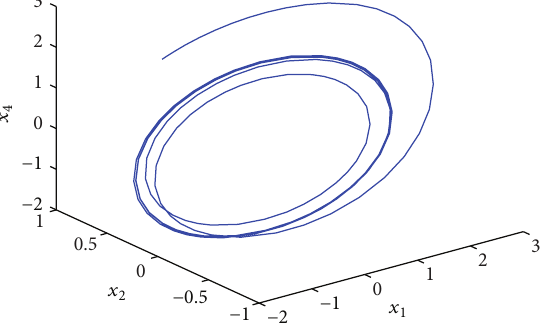
Figure 14: Phase portrait of (2) with 𝑐 = 1 in ( 𝑥 1 ,𝑥 2 , 𝑥 4 ) space.